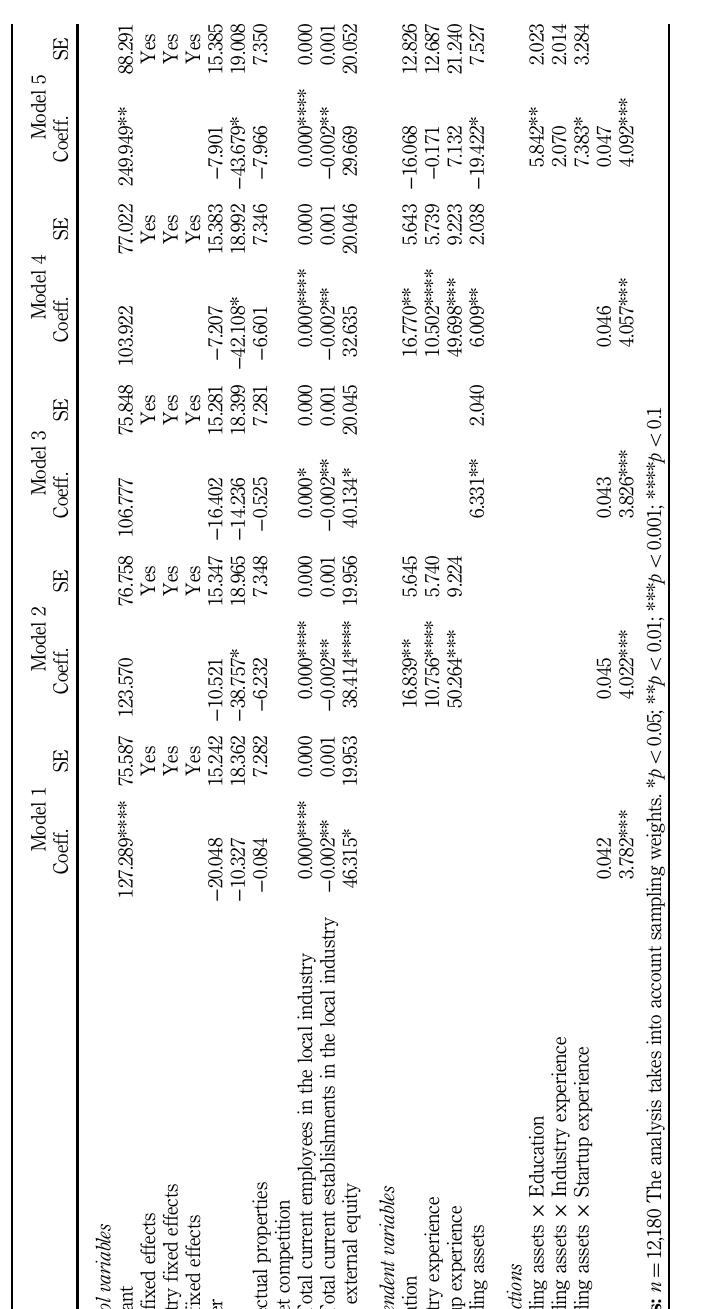
Table II. Regression